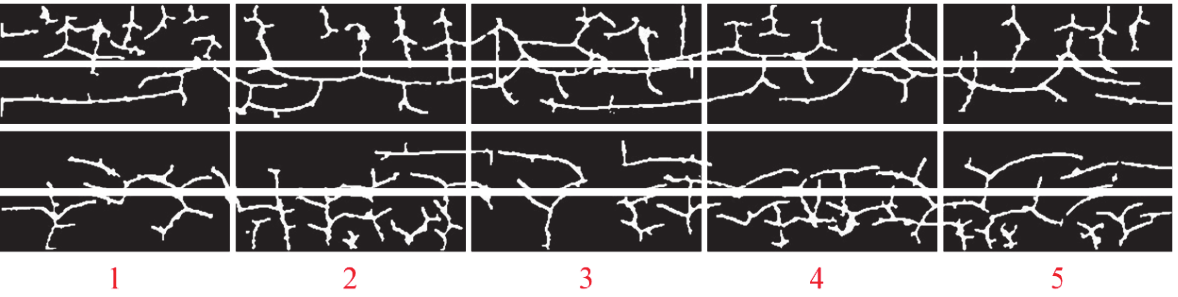
Figure 5. Divide four images horizontally and five images vertically, and calculate the values of α ( q ) and f ( q ) of each subimage.